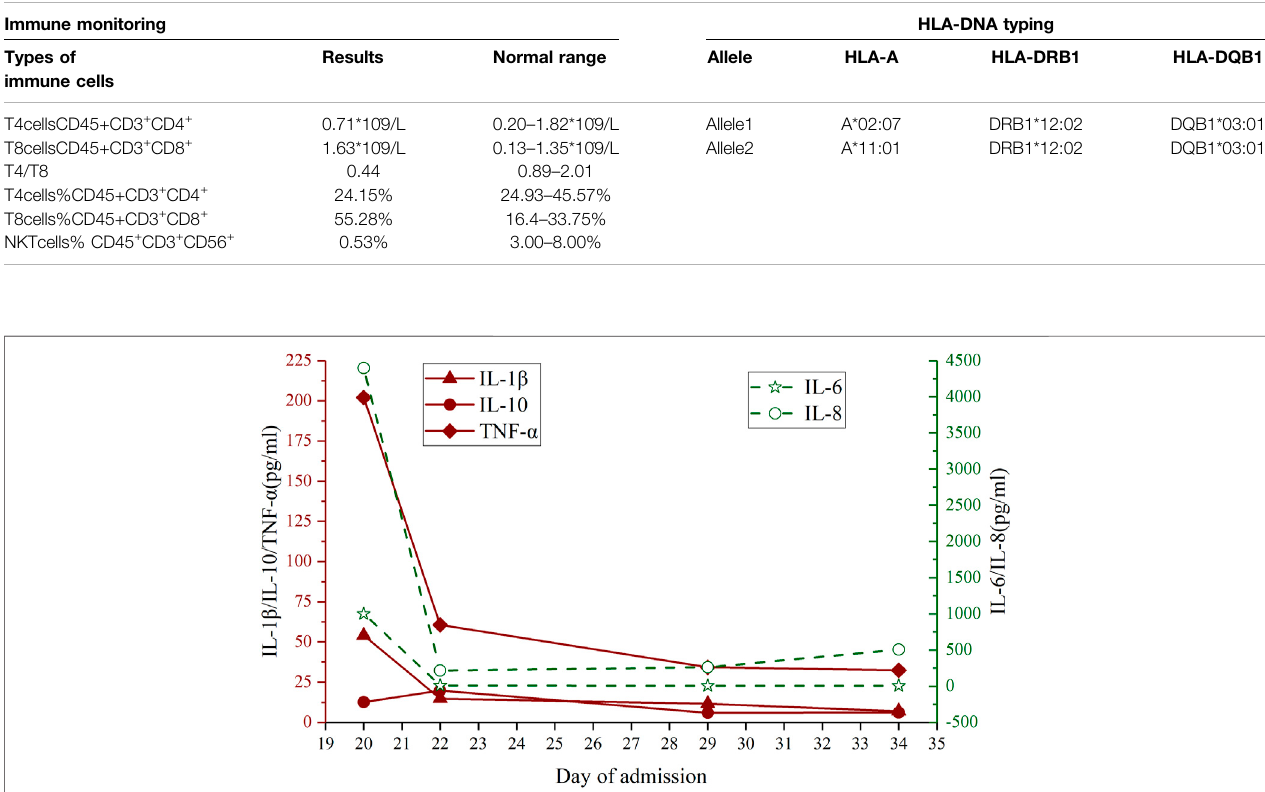
Frontiers in Pharmacology |